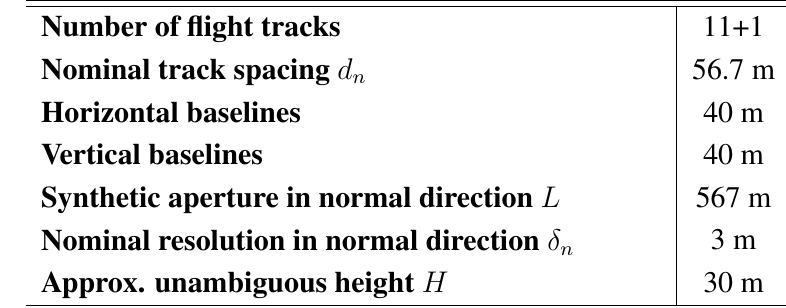
Table 2. Nominal parameters used in the set-up of the P-band tomographic SAR